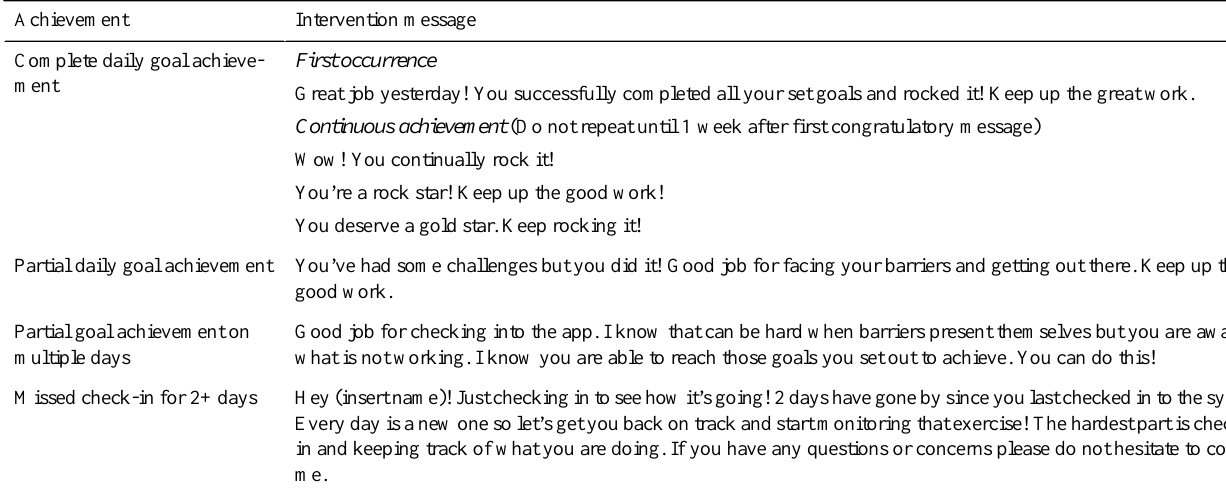
Table 2. Exercise counselor intervention timeline.